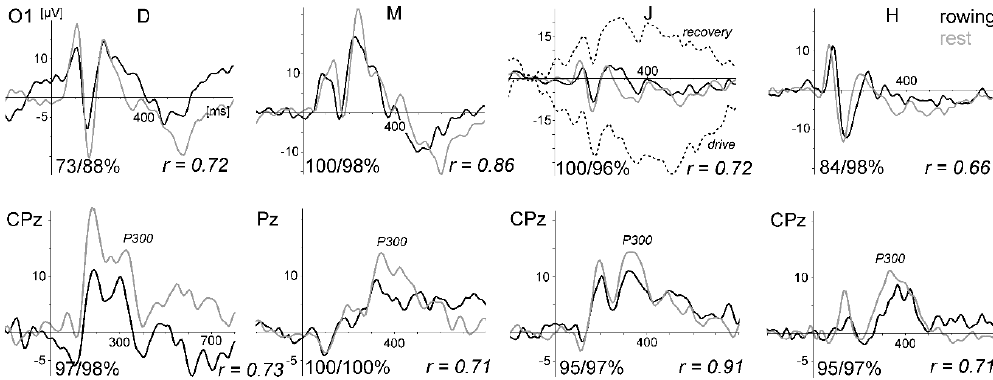
Figure 5. ERPs of the visual oddball task comparing rowing and rest for all four subjects (D, M, J, and H) of pilot Study 3. Upper graphs: VEPs evoked by the frequent checkerboard stimulus at electrode site O1 (referenced to Cz). Below: the P300 waveform at CPz / Pz (referenced to linked mastoids), which was larger during rest. The vertical line marks the stimulus onset. The numbers at the bottom of each graph present the percentage of artefact-free trials included in the averages for the rowing and rest of the chosen electrode site and the correlation coe ffi cients. Deviant stimulus condition is not shown. For the frequent stimulus of subject J, the ERPs of the rowing condition, separated into drive (with force) and recovery phases of the rowing movement (without excluding artefactual trials), are presented additionally. In this recording, the VEP at electrode site O1 was overlaid by large movement-related drift artefacts, which cancelled each other out when all trials (drive and recovery) are included in the average